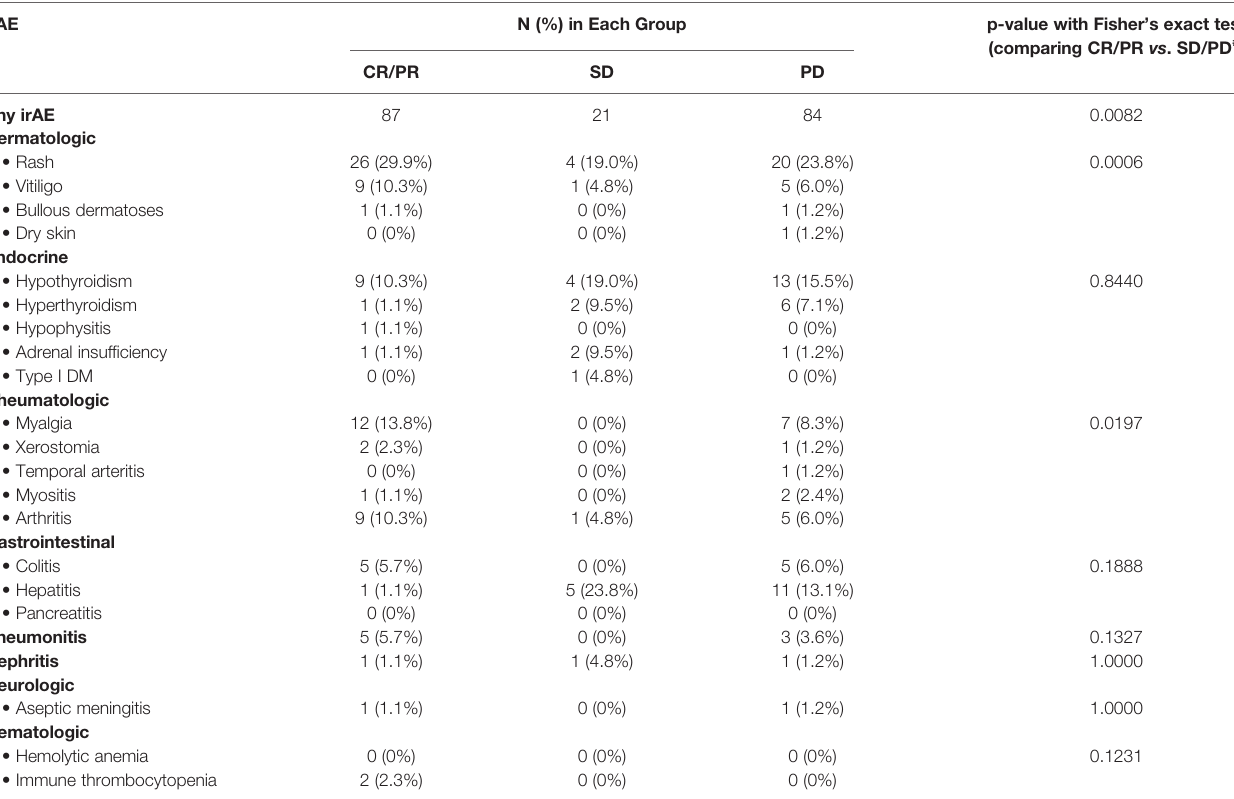
TABLE 2A | Summary of irAE occurrence by response (Current).